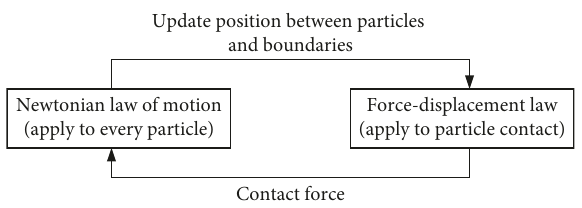
Contact Figure 7: The calculation process of PFC